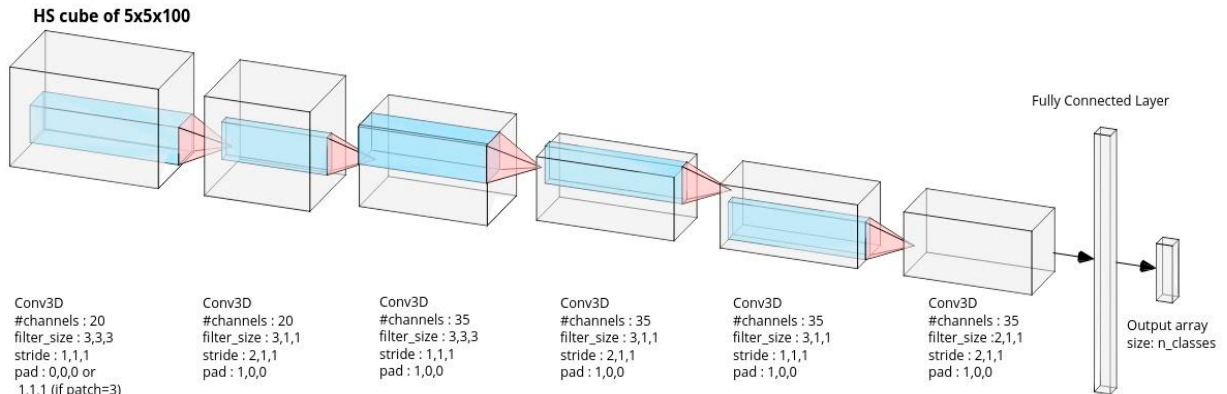
Figure 5. Convolutional neural network architecture: The input is an HSI sub-volume centered on a given pixel, with 5 × 5 spatial dimensions and 100 wavelength dimensions. Down-sampling convolutional operations are applied to transform the input to a final 1D feature space vector, which is followed by a final fully connected layer to produce the tissue prediction scores.